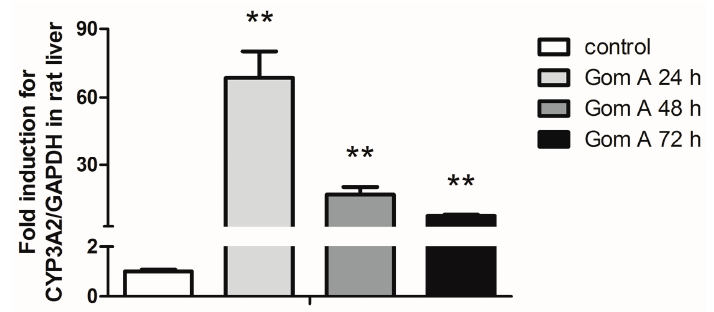
Figure 6. Effect of Gom A on rat liver CYP3A mRNA expression. Gom A was administrated at single-dose of 20.8 mg/kg (50 µmol/kg). The hepatic CYP3A2 mRNA expression was determined 24, 48 and 72 h after Gom A administration and was normalized to GAPDH. Results were mean ± SD of five rats for each group.